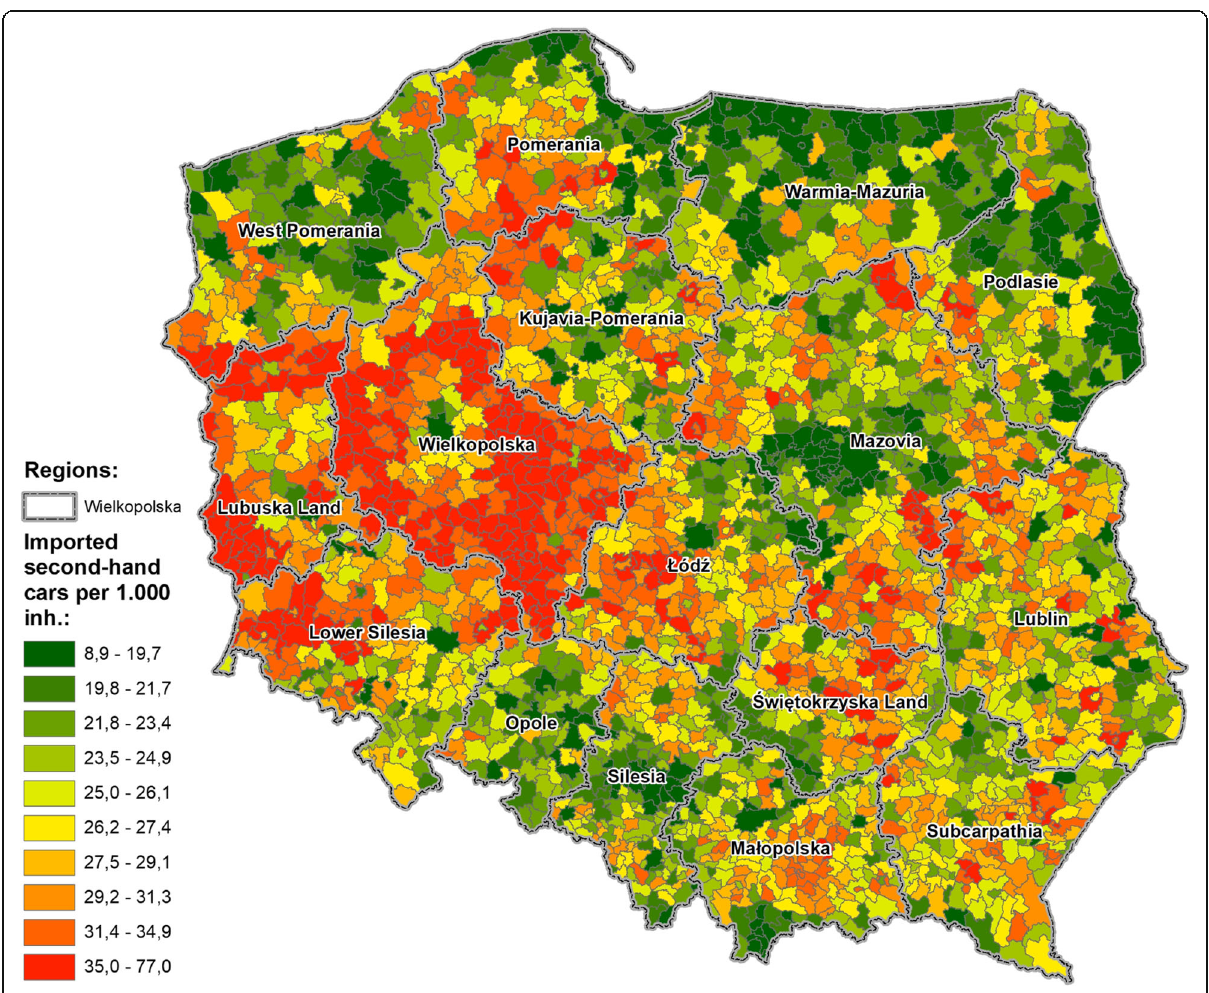
Fig. 7 Spatial structure of imported second-hand cars in Poland. Source: own elaboration based on the Central Vehicle Agency